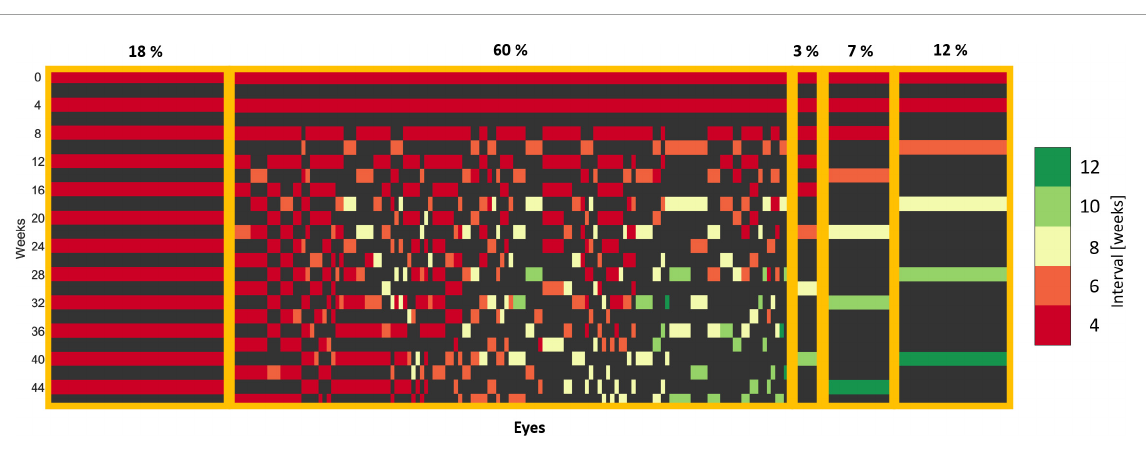
FIGURE3 Treatment patterns of eyes in the T&E arm. Each column corresponds to one eye. Each row corresponds to a visit and the corresponding 4-week interval. A loading dose of two injections is apparent, as all the eyes received an injection at the baseline and the first follow-up visit. The eyes with an individual treatment were sorted by the last extension